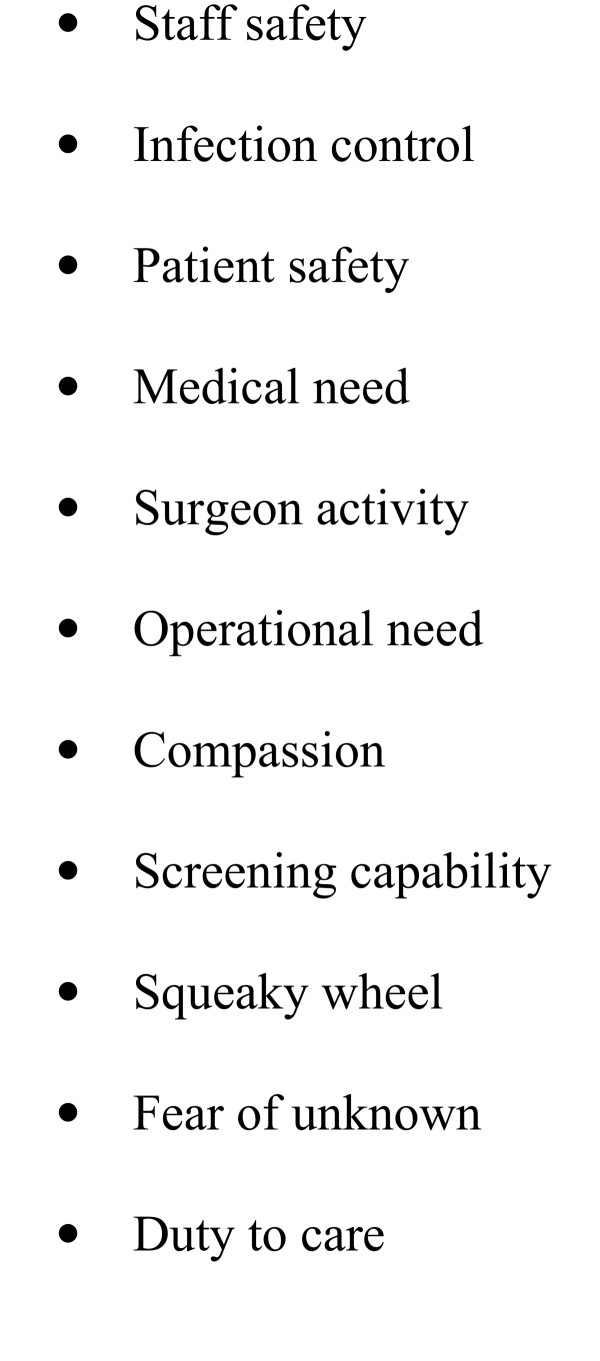
Reasons justifying priority setting decisions